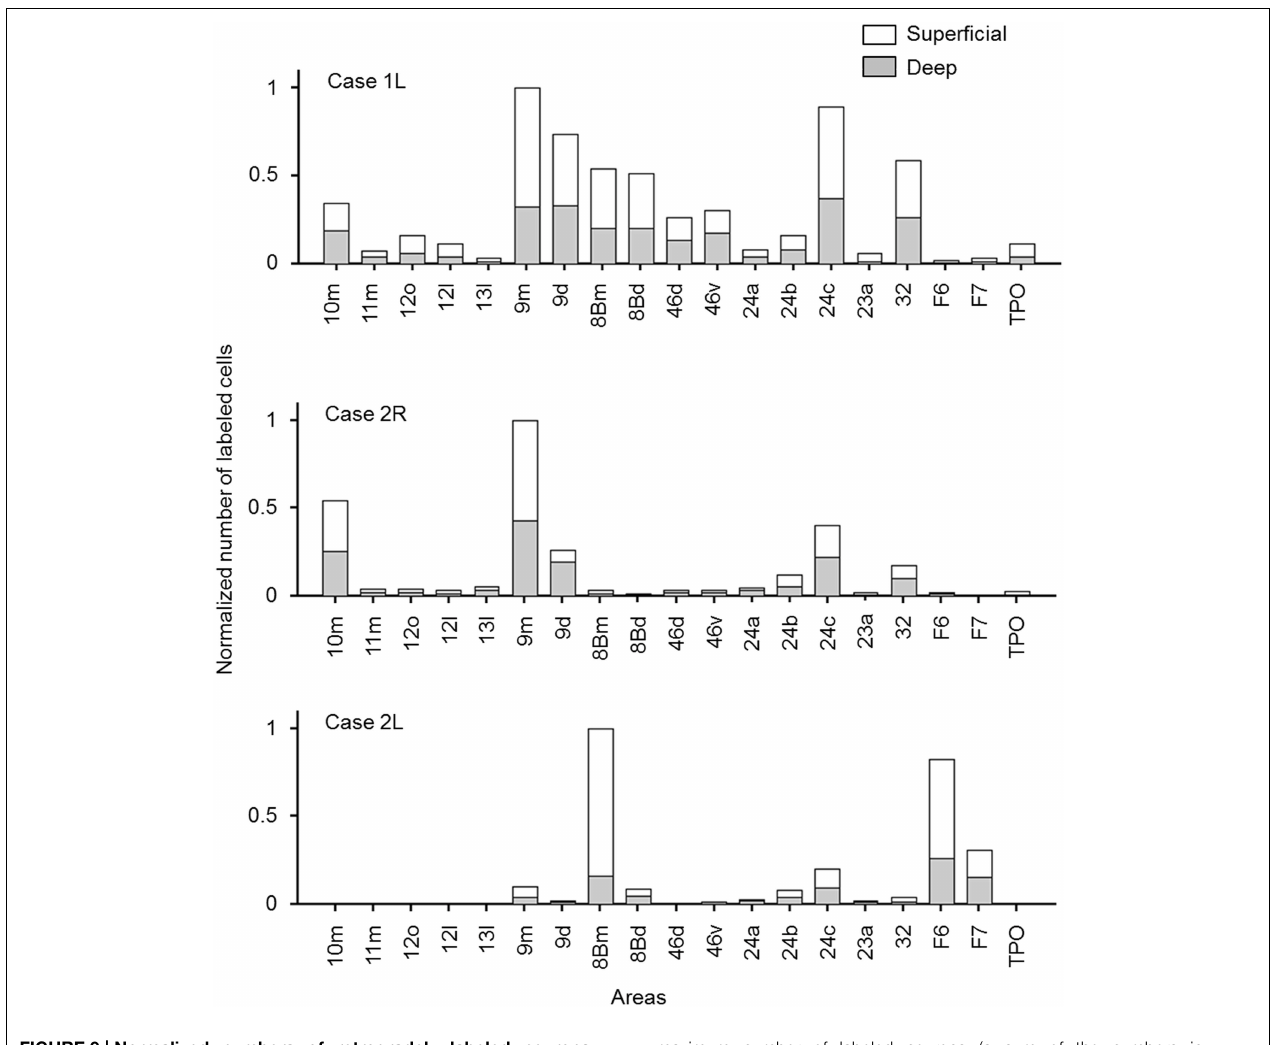
maximum number of labeled neurons (a sum of the numbers in superficial and deep layers). Only the cortical areas in which labeled neurons were found in at least two of the three cases were